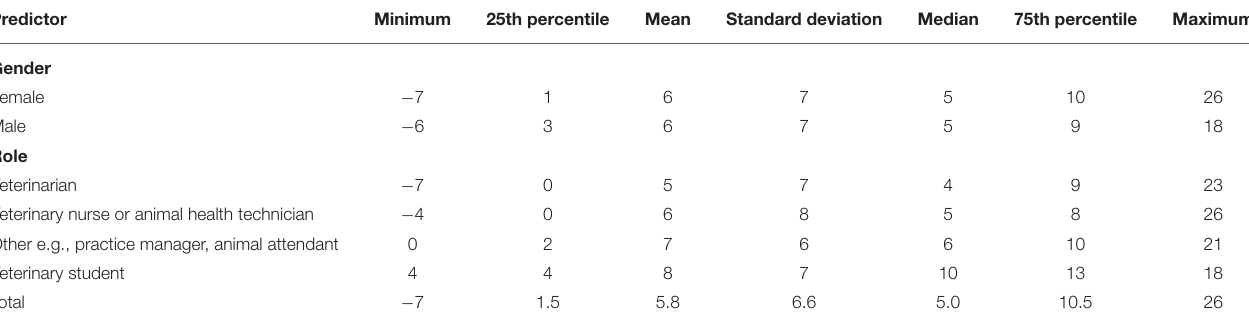
TABLE 5 | Summary statistics for the outcome Euro-MCD change score overall and by categories of the categorical predictor variables. Predictor